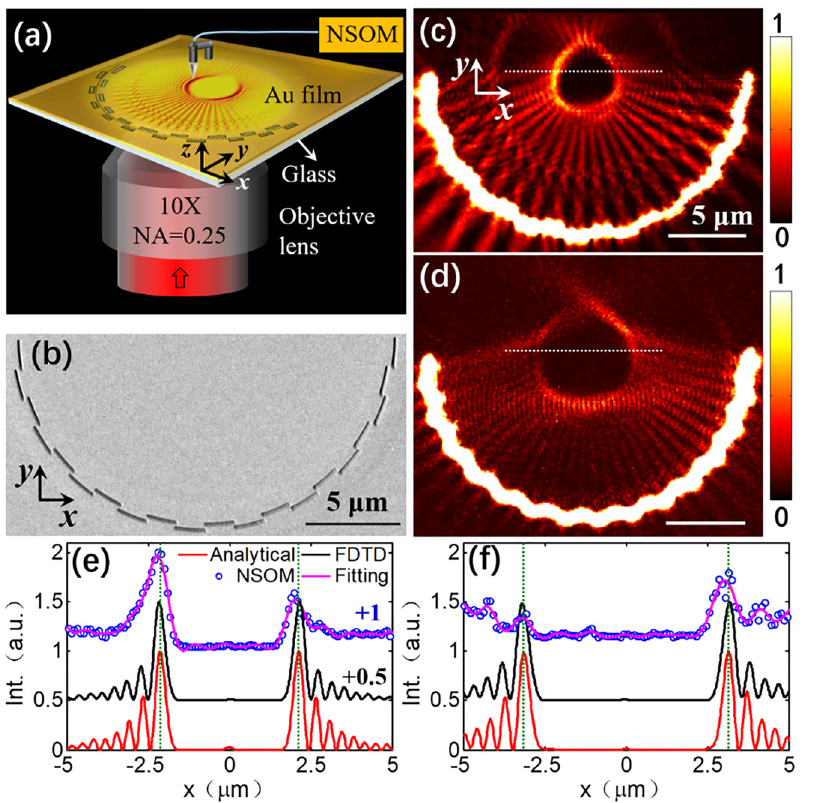
from the bottom. Then the SPP fi